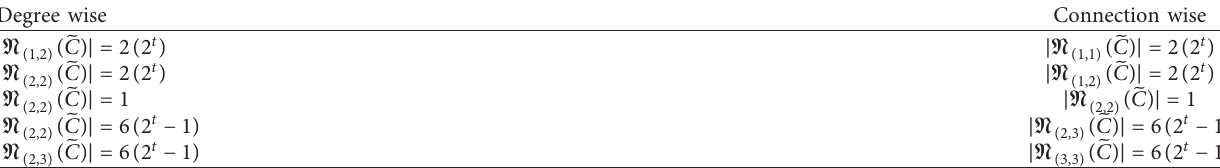
Table 2: Total amount of edges on degree and connection